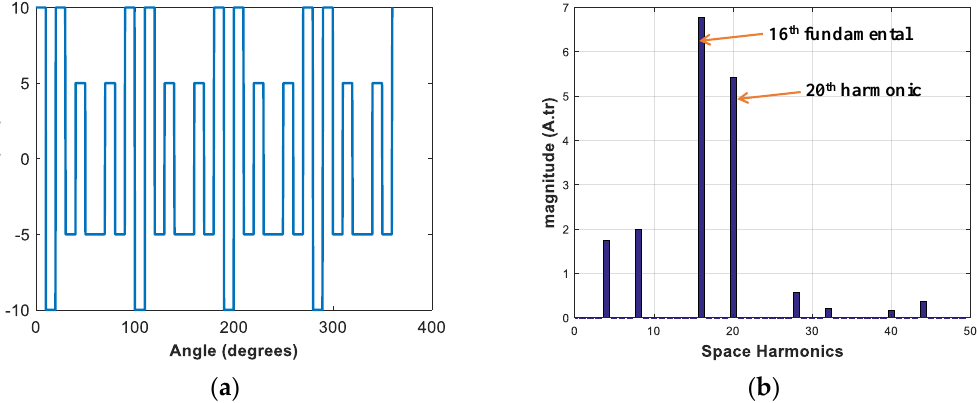
Figure 3. MMF harmonic spectrum of three-phase IPM with fundamental current: ( a ) MMF; ( b ) harmonic spectrum.